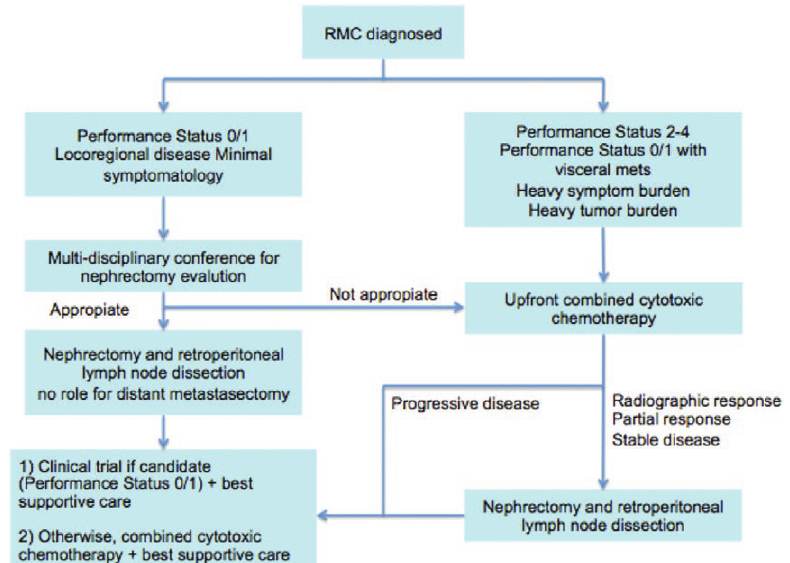
Figure 1. Treatment algorithm by Shah et al. (37). This algorithm suggests the need for a multidisciplinary approach for the effective management of renal medullary